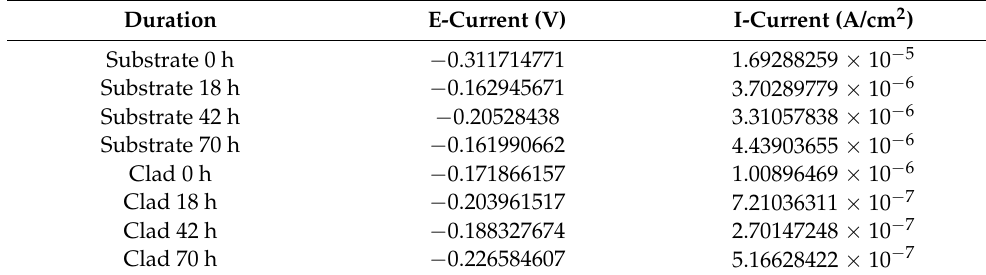
Figure 6. Tafel plot of: ( a ) Substrate (316L steel) and ( b ) Cladded samples at different time intervals. Table 3. Corrosion analysis data.